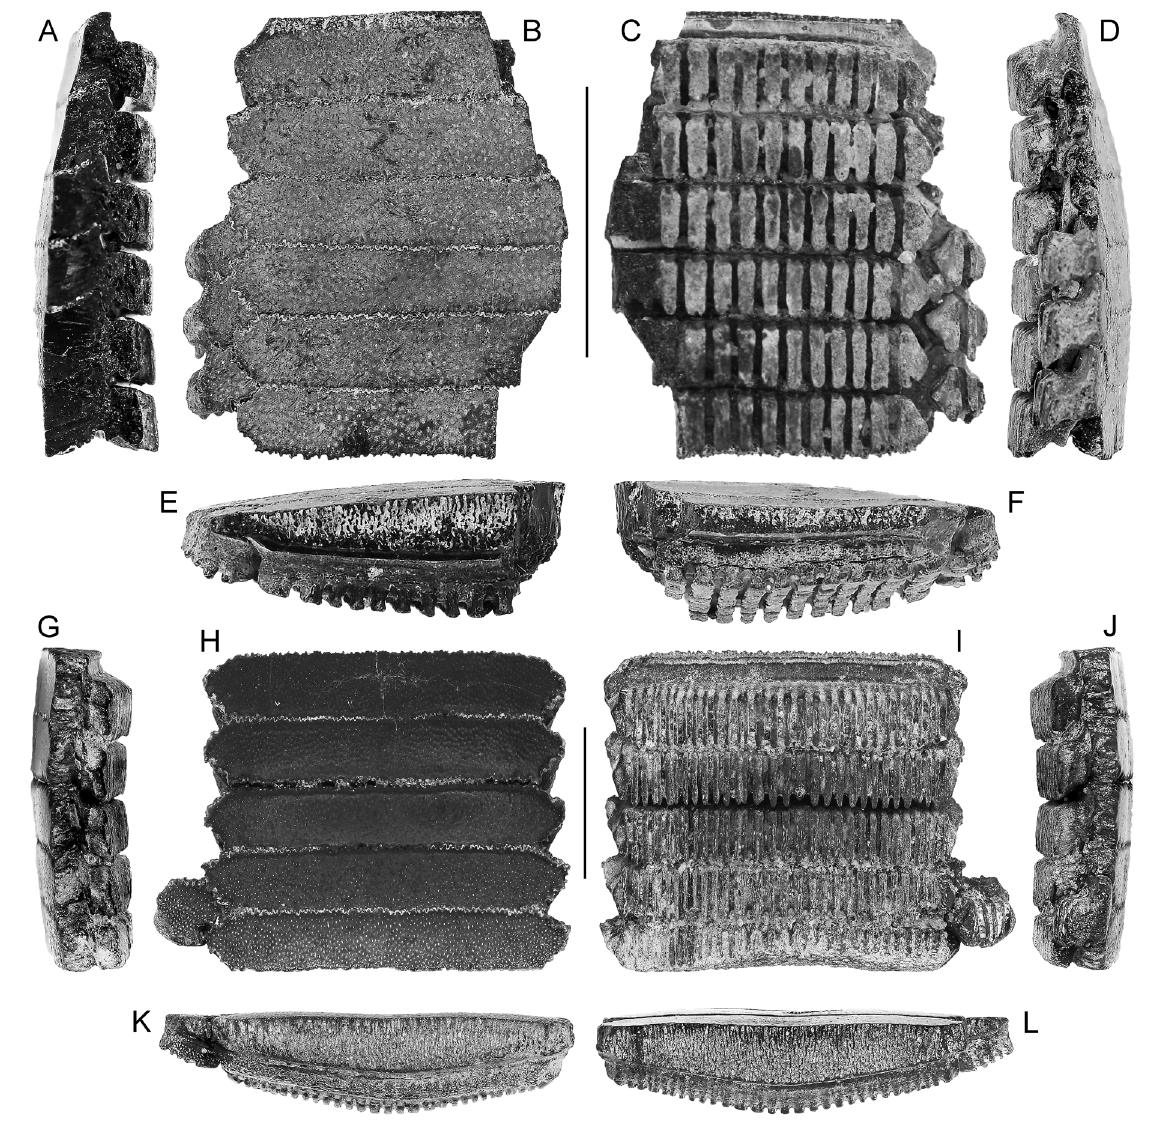
Fig. 48. Myliobatis sp. 2, tooth plates. A–F . MSC 35008, upper tooth plate, Tallahatta/Lisbon formation contact zone. A . Left lateral view. B . Oral view. C . Basal view. D . Right lateral view. E . Lingual view. F . Labial view. G–L . MSC 35007, lower tooth plate, Tallahatta/Lisbon formation contact zone. G . Right lateral view. H . Oral view. I . Basal view. J . Left lateral view. K . Lingual view. L . Labial view. Labial at top in oral, basal, and lateral views. Scale bars = 1